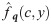
Parameterization of the excitation function.The helper bilinear function f^q(c,y) is described by four values qaa, qab, qba, qbb in four interpolation points.